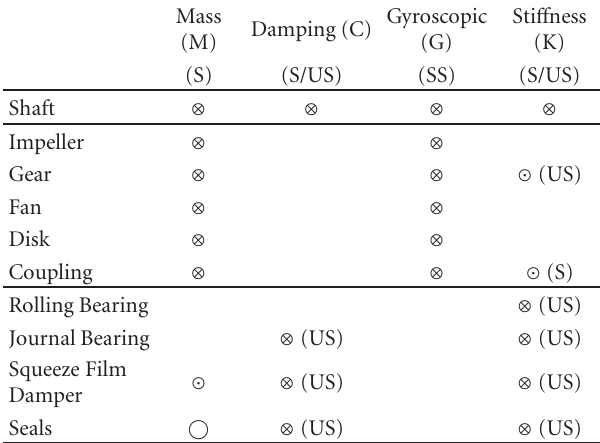
Table 1: Component contributions to rotor dynamic equation of motion; S = symmetric, SS = skew-symmetric, and US =